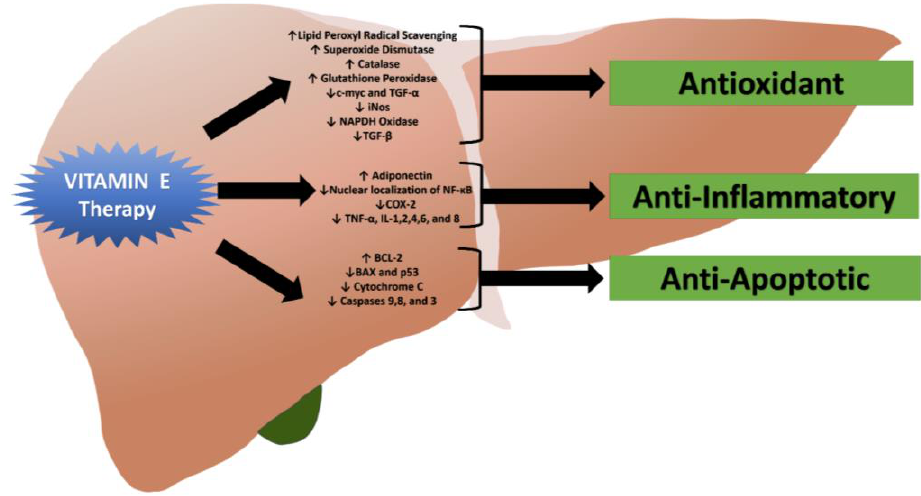
Figure 1. The effects of vitamin E in patients with nonalcoholic steatohepatitis (NASH).